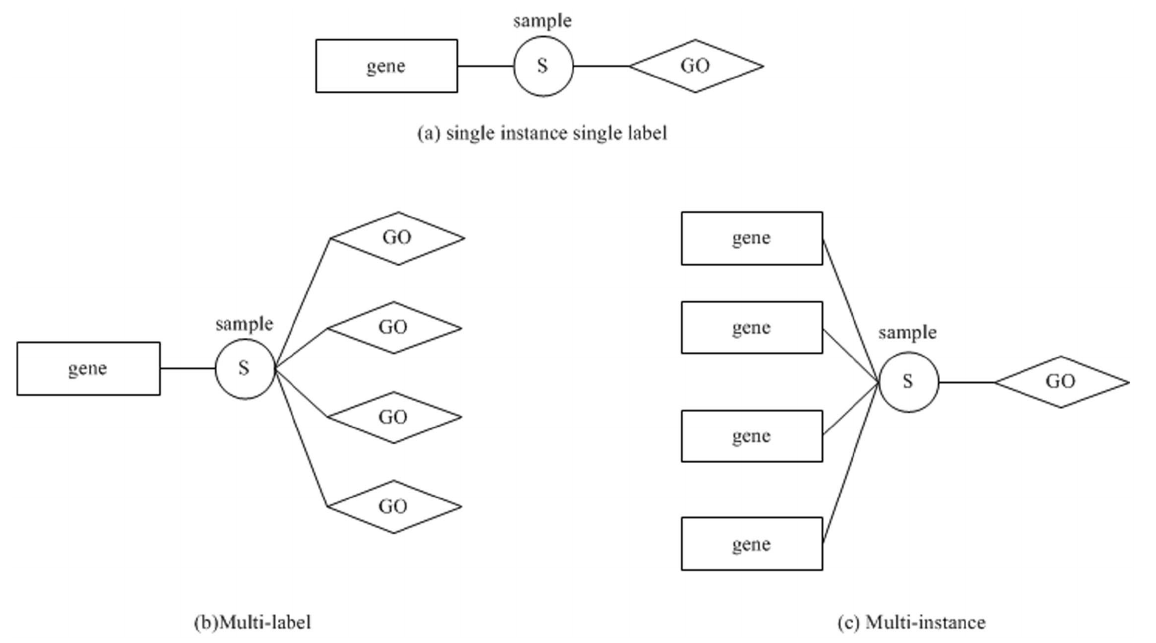
Figure 1. Three types of learning task. (a) A gene is treated as a sample and owns one GO term only, which is called the single instance single label. (b) A gene is treated as a sample and annotated by multiple GO terms. This relationship between gene and GO terms is multi-label. (c) Multiple genes are treated as samples and share the same GO term. The relationship between genes and GO term is called multi-instance.